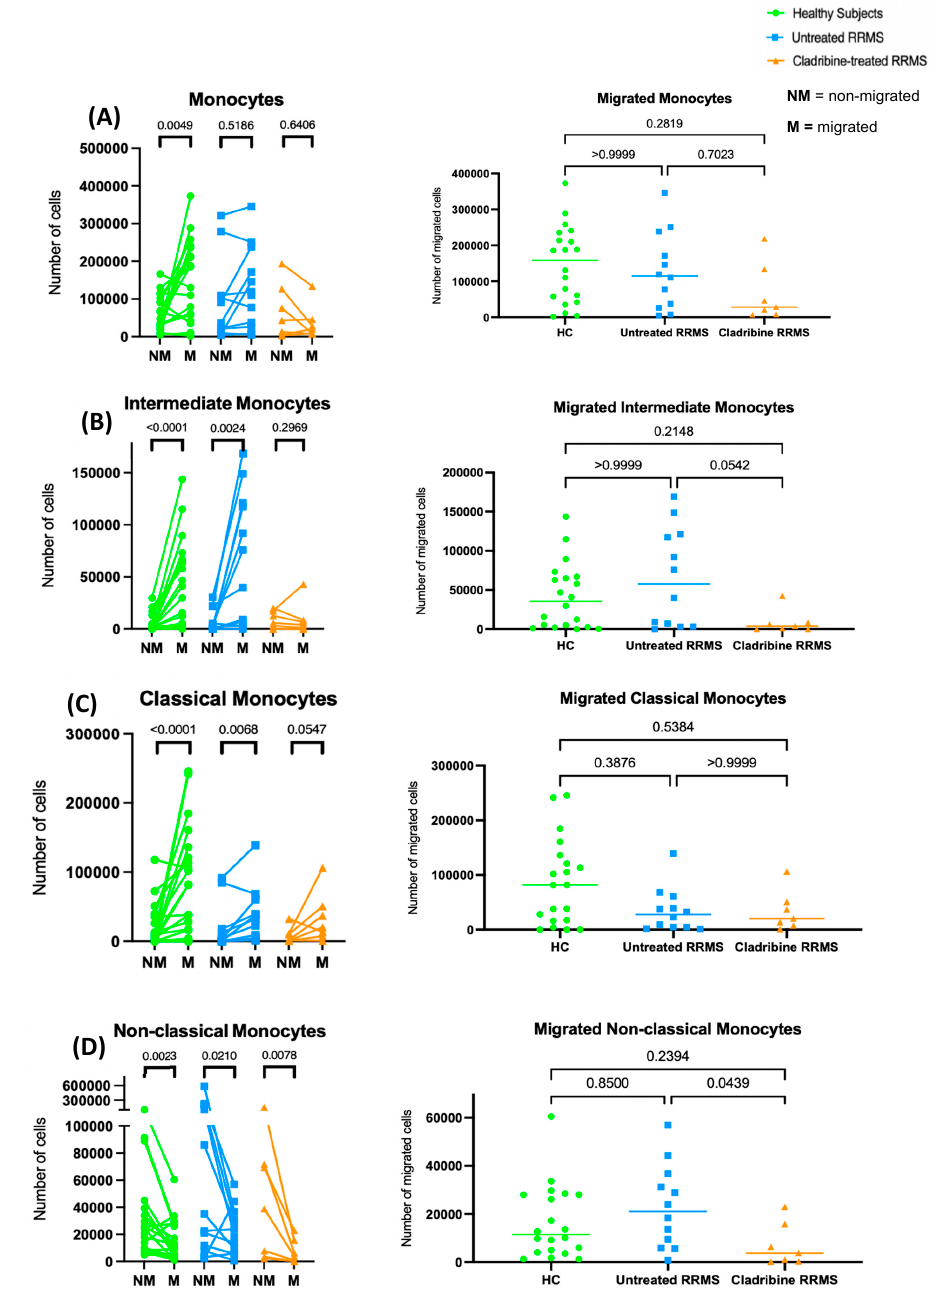
Figure 4. Cladribine impairs intermediate monocyte (CD14 + CD16 + ) transmigration in RRMS patients. PBMCs from healthy subjects ( n = 20), untreated RRMS patients ( n = 12) and cladribine–treated